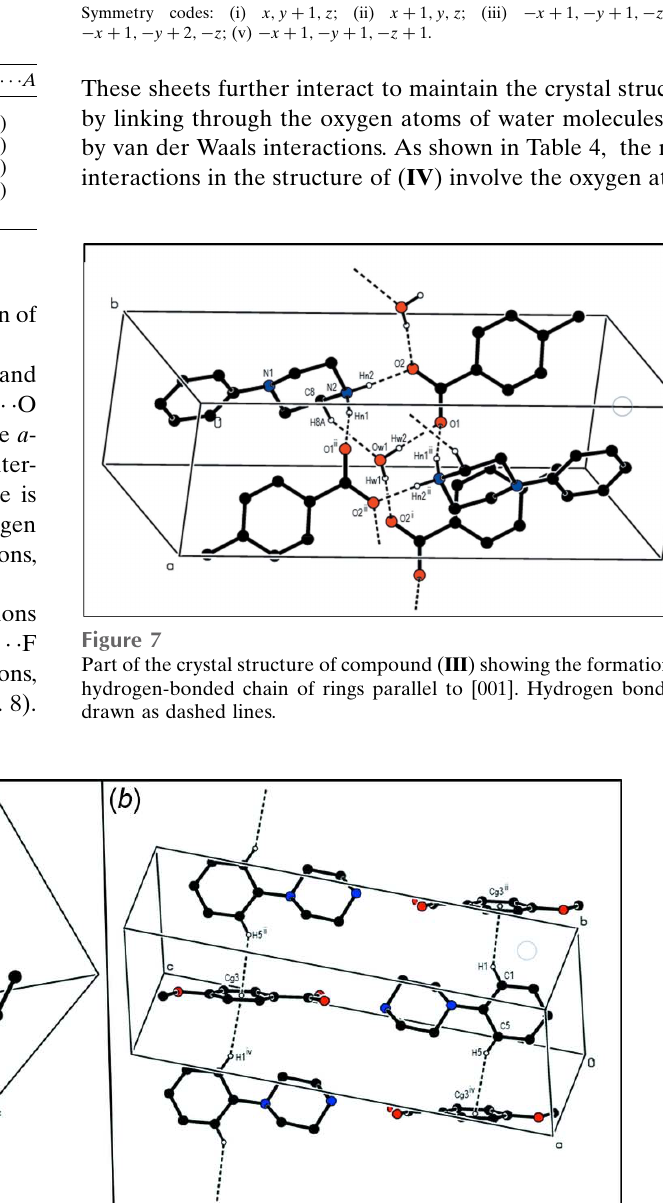
Figure 6 Parts of the crystal structure of compound ( II ) showing ( a ) the formation of hydrogen-bonded ribbons parallel to [010] and ( b ) a general view of the C— H (cid:2)(cid:2)(cid:2) (cid:2) interactions parallel to [010]. Hydrogen bonds and C—H (cid:2)(cid:2)(cid:2) (cid:2) interactions are drawn as dashed lines.